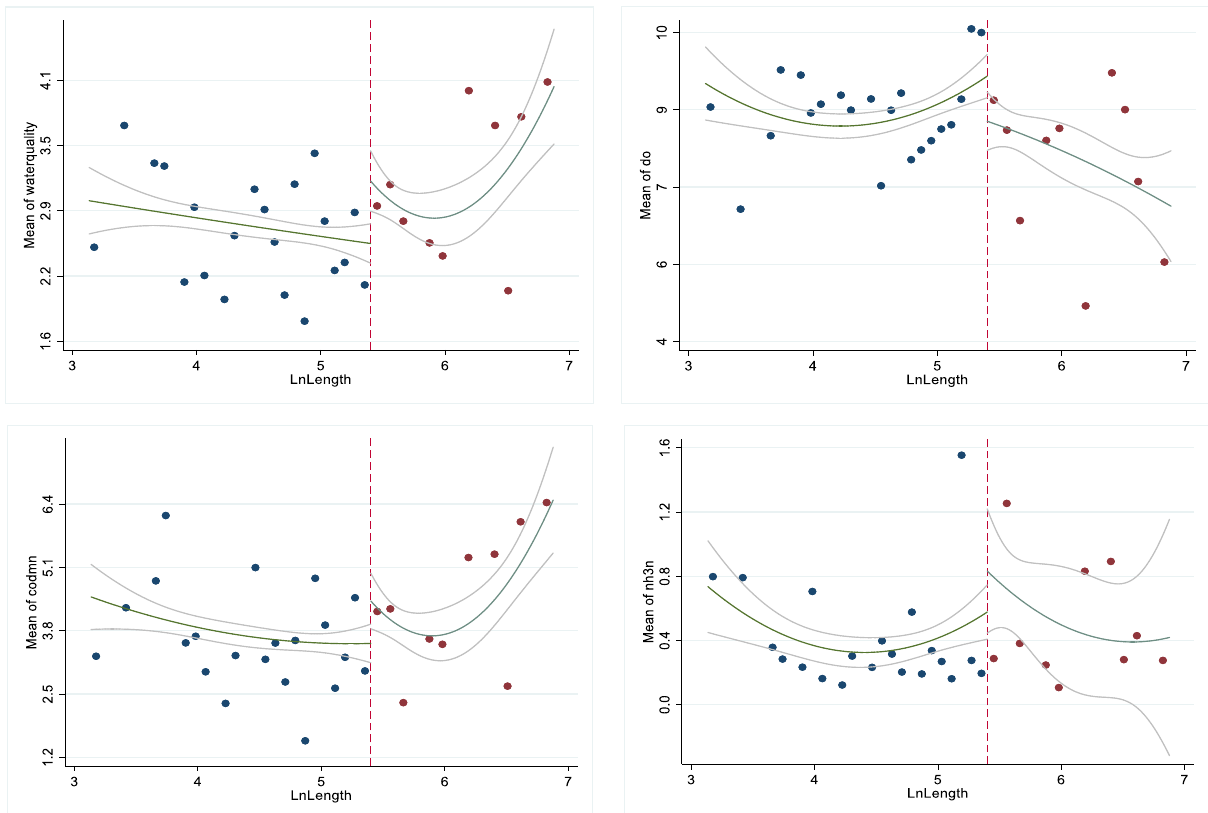
Figure 2. The discontinuities of river length after the implementation of RCS. Note: The x-coordinate represents the loga- rithm of the river length, and the y-coordinate represents the water quality.